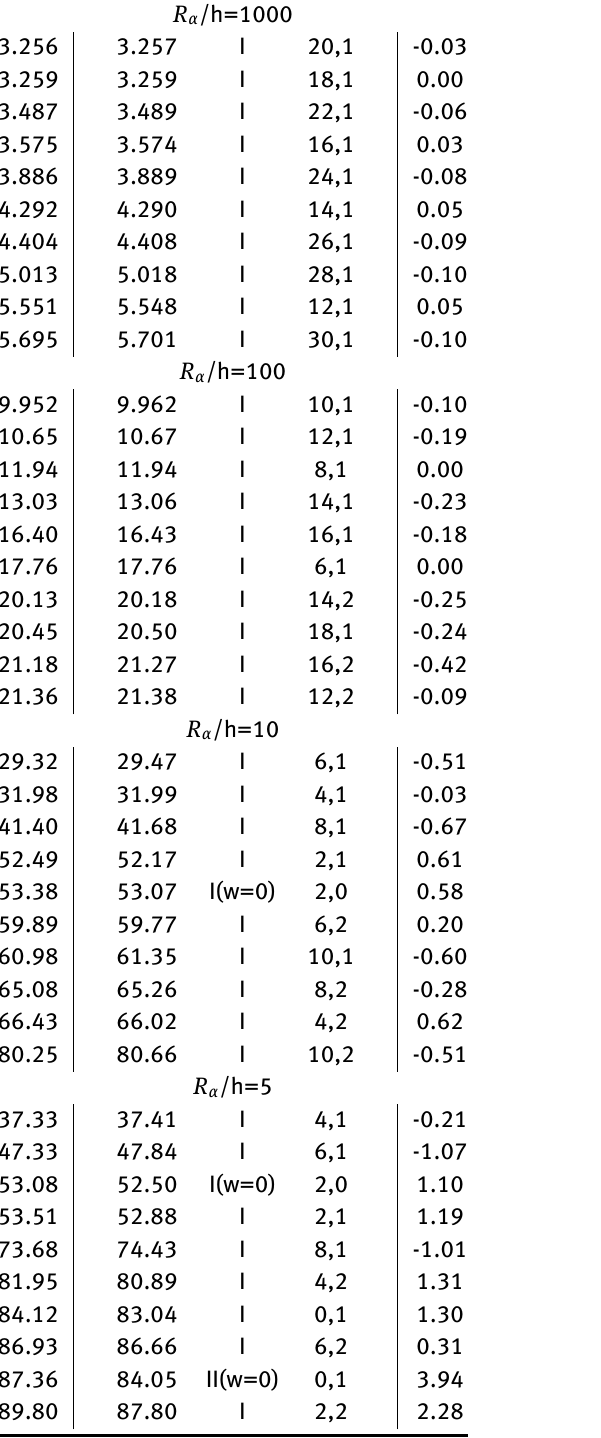
Table 14: Seventh benchmark, simply supported composite plate 90 ∘ /0 ∘ /90 ∘ with thickness ratios a/h=1000, a/h=100, a/h=20 and a/h=10. First ten frequencies in Hz, comparison between the present 3D exact solution and the 2D FE solution via Nastran. The error is calculated as ∆ (%) = FE −3 D × 100 3 D